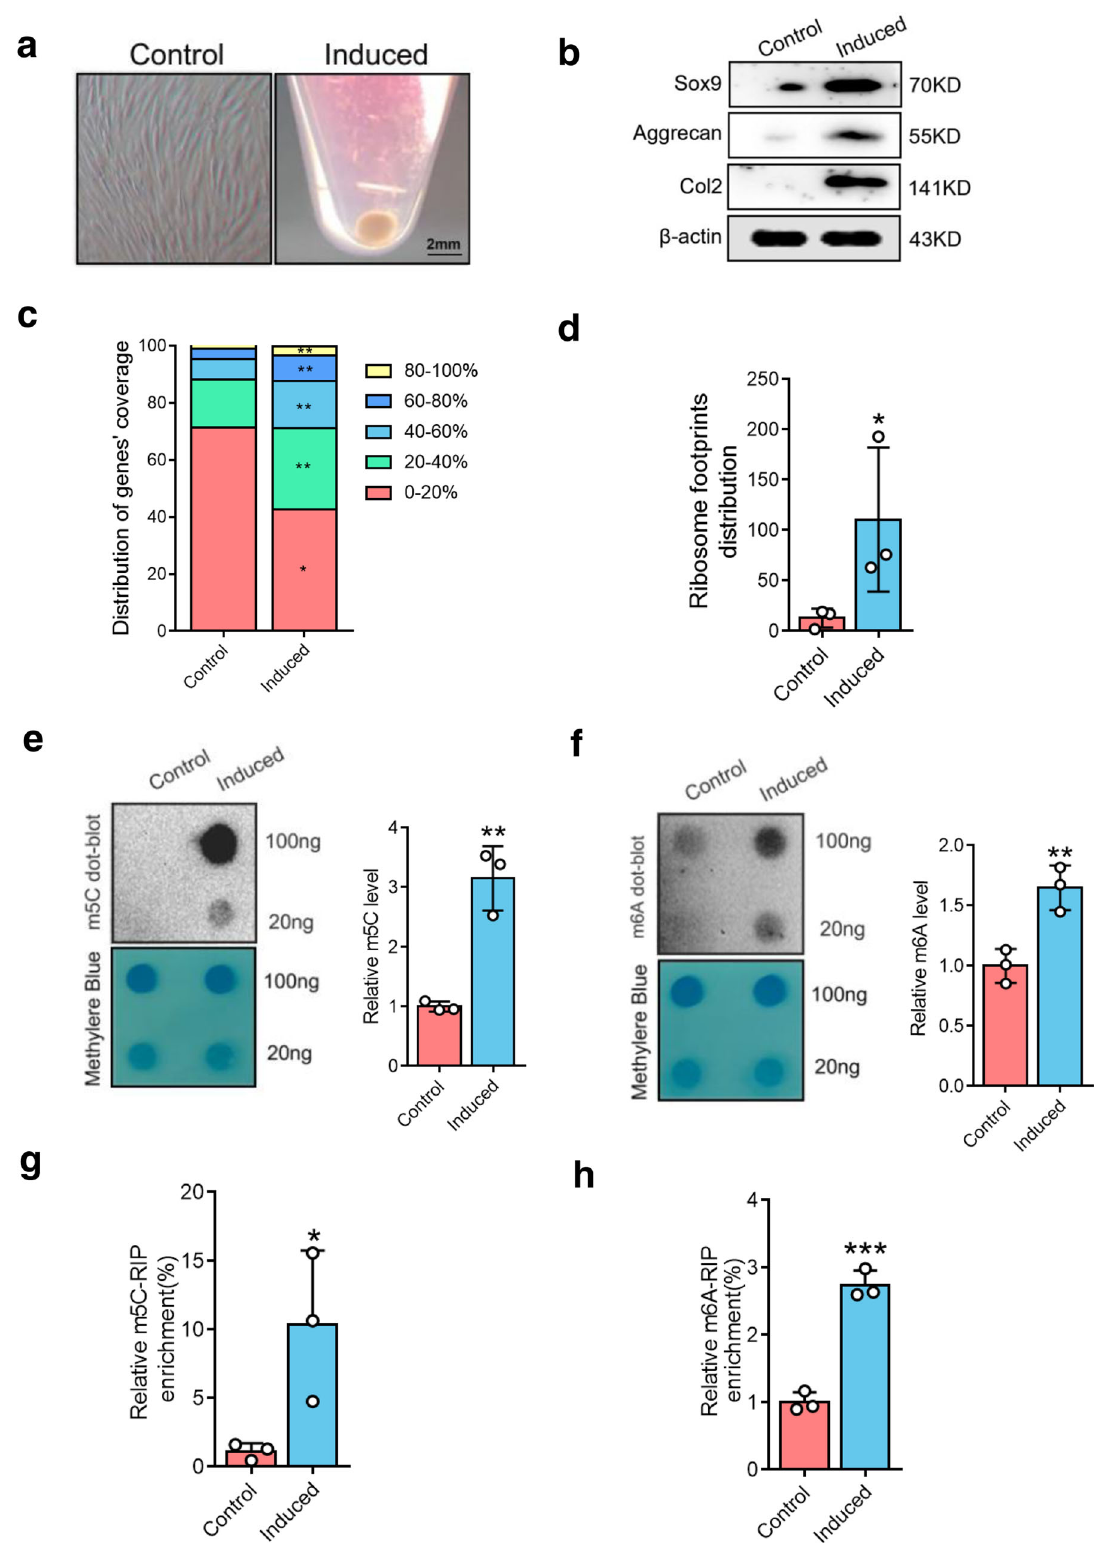
chondrogenic differentiation (Fig. 2c, d). Conversely, chondro- genic pellets could not be induced when Nsun4 and Mettl3 were silenced (Fig. 2e). Chondrogenic differentiation markers, includ- ing Sox9, Col2 and aggrecan, were also suppressed compared with those in NC cells (Fig. 2f, g). To investigate whether Nsun4 and